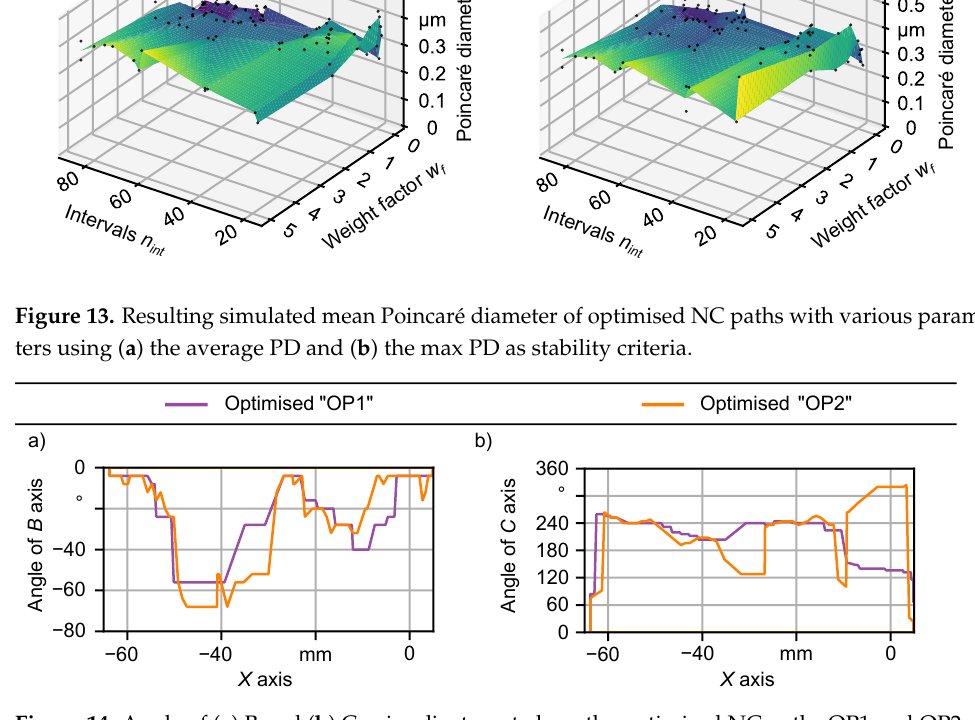
inside one interval had minor influences on the optimisation results, as presented in Figure 13. Both methods tend to prefer a frequent adaption of the position of the B (cid:48) and C (cid:48) axis, but neither of them could be identified as the superior stability criterion for